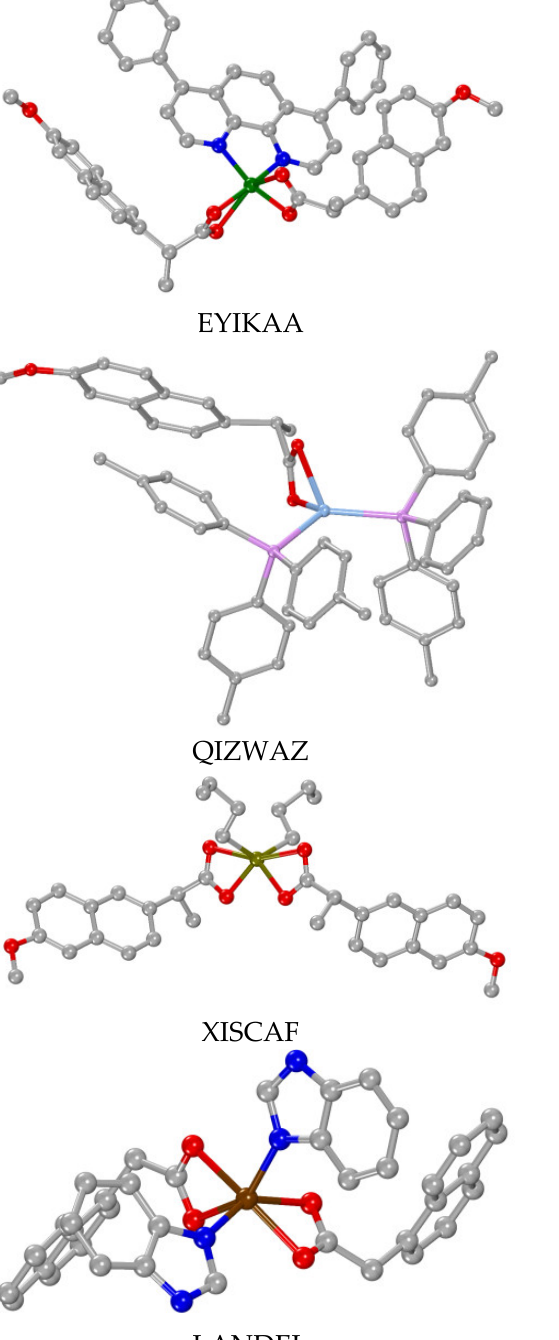
Figure 16. Molecular structures of selected complexes bearing bidentate chelating ligands. EYIKAA=[Cu(NAP– O,O (cid:48) ) 2 (4,7–diPhphen)] [55], NEQLIF = [Zn(N1A–O,O (cid:48) ) 2 (phen)] [57], QIZWAZ = [Ag(NAP–O,O (cid:48) )(tptp) 2 ] [50], YAVLIS = [Ni(N1A–O,O (cid:48) ) 2 (Hbzmd–N3) 2 ] · H 2 O [54], XISCAF = [( n –Bu) 2 Sn(NAP–O,O (cid:48) ) 2 ] [59], ZAS- ZUQ = [Cd(NAP–O,O (cid:48) ) 2 (H 2 O) 2 ] · H 2 O [46] and LANDEL= [Mn(N1A–O,O (cid:48) ) 2 (Hbzmd) 2 ] · H 2 O [53]. Hydro- gen atoms, disordered atoms and solvate molecules are omitted for clarity reasons. Color code for atoms: C: gray, O: red, N: blue, Mn: brown, Cu: green, P: violet, Zn: magenta, Ag: cyan; Cd: yellow, Ni: petrol green and Sn: dark yellow. The figures of the structures were adapted from the corresponding references.